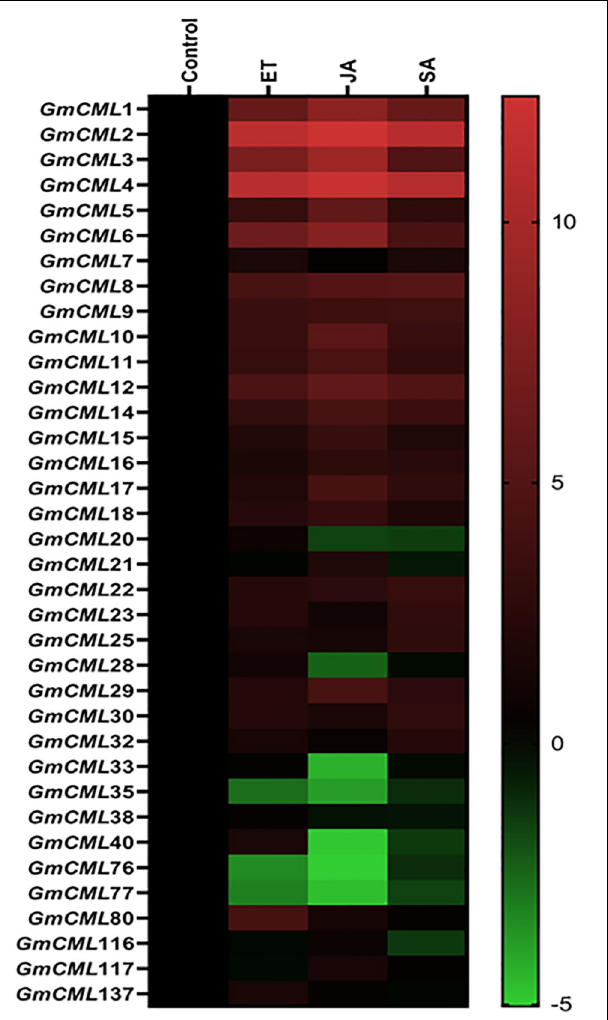
FIGURE 2 | Heat map showing expression profile of GmCMLs upon S. litura -infestation and wounding. The expression profile of GmCML s upon S. litura -infestation and wounding is represented as heat map, generated with the help of Graphpad Prism software using log 2 values of expression data obtained from qPCR. The qPCR data were analyzed utilizing 2 − (cid:49)(cid:49) CT method and statistical analysis was performed using ANOVA and Tukey’s test ( P < 0.05).